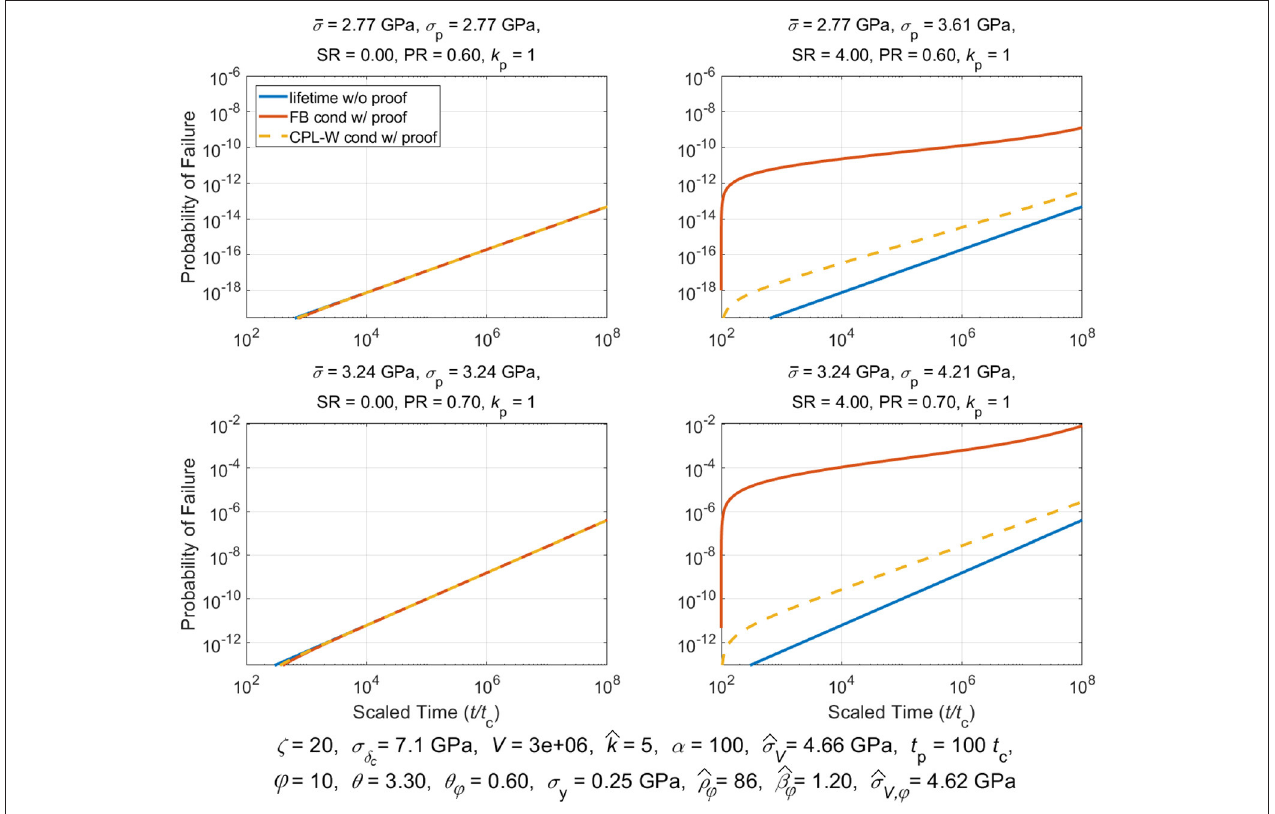
FIGURE 8 | COPV where tows are modeled as being arranged in a hexagonal array under (56) for the number of overloaded tows around a cluster, and where ϕ and σ y =